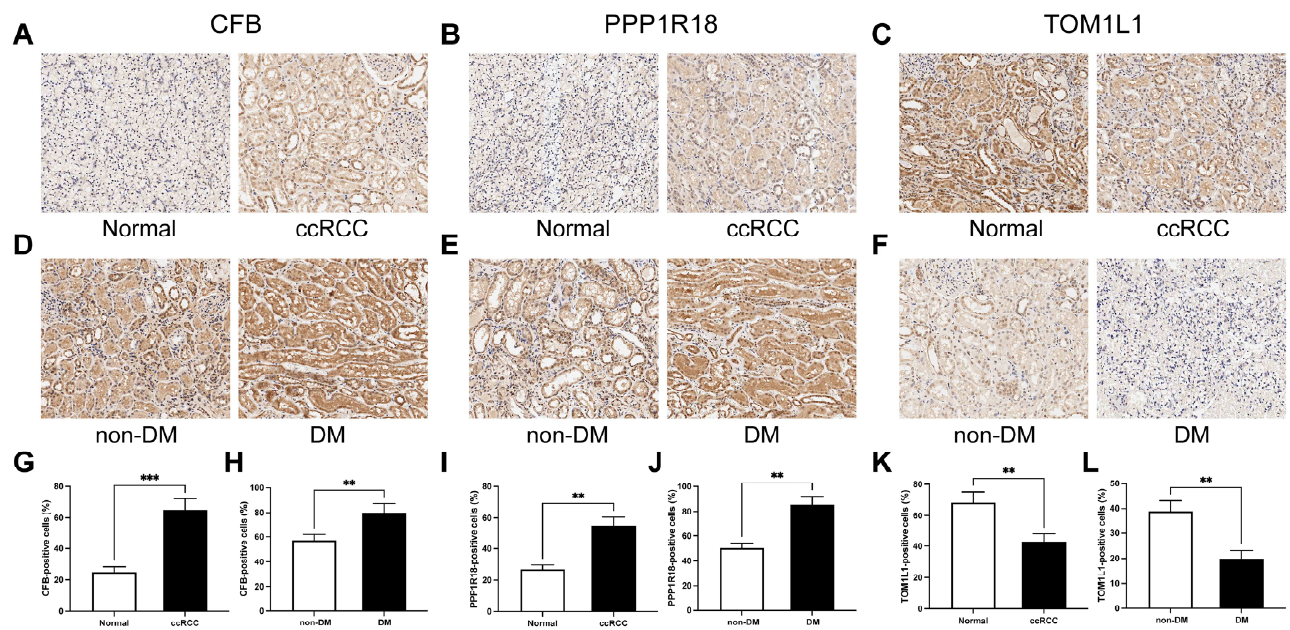
Figure 12. Validation of the expression of three key DMA-RMSGs using IHC. The differential protein levels of CFB ( A ), PPP1R18 ( B ), and TOM1L1 ( C ) between normal and ccRCC tissues. IHC staining revealed the distinct expression patterns of CFB ( D ), PPP1R18 ( E ), and TOM1L1 ( F ) between the nondistant metastasis and distant metastasis samples. The positive cells of CFB ( G ), PPP1R18 ( I ), and TOM1L1 ( K ) between normal and ccRCC tissues. The positive cells of CFB ( H ), PPP1R18 ( J ), and TOM1L1 ( L ) between the nondistant metastasis and distant metastasis samples. ** p < 0.01, *** p < 0.001; ns, no significance. DMA-RMSGs, distant metastasis-associated resting mast-cell-sensitive genes; IHC, immunohistochemistry.